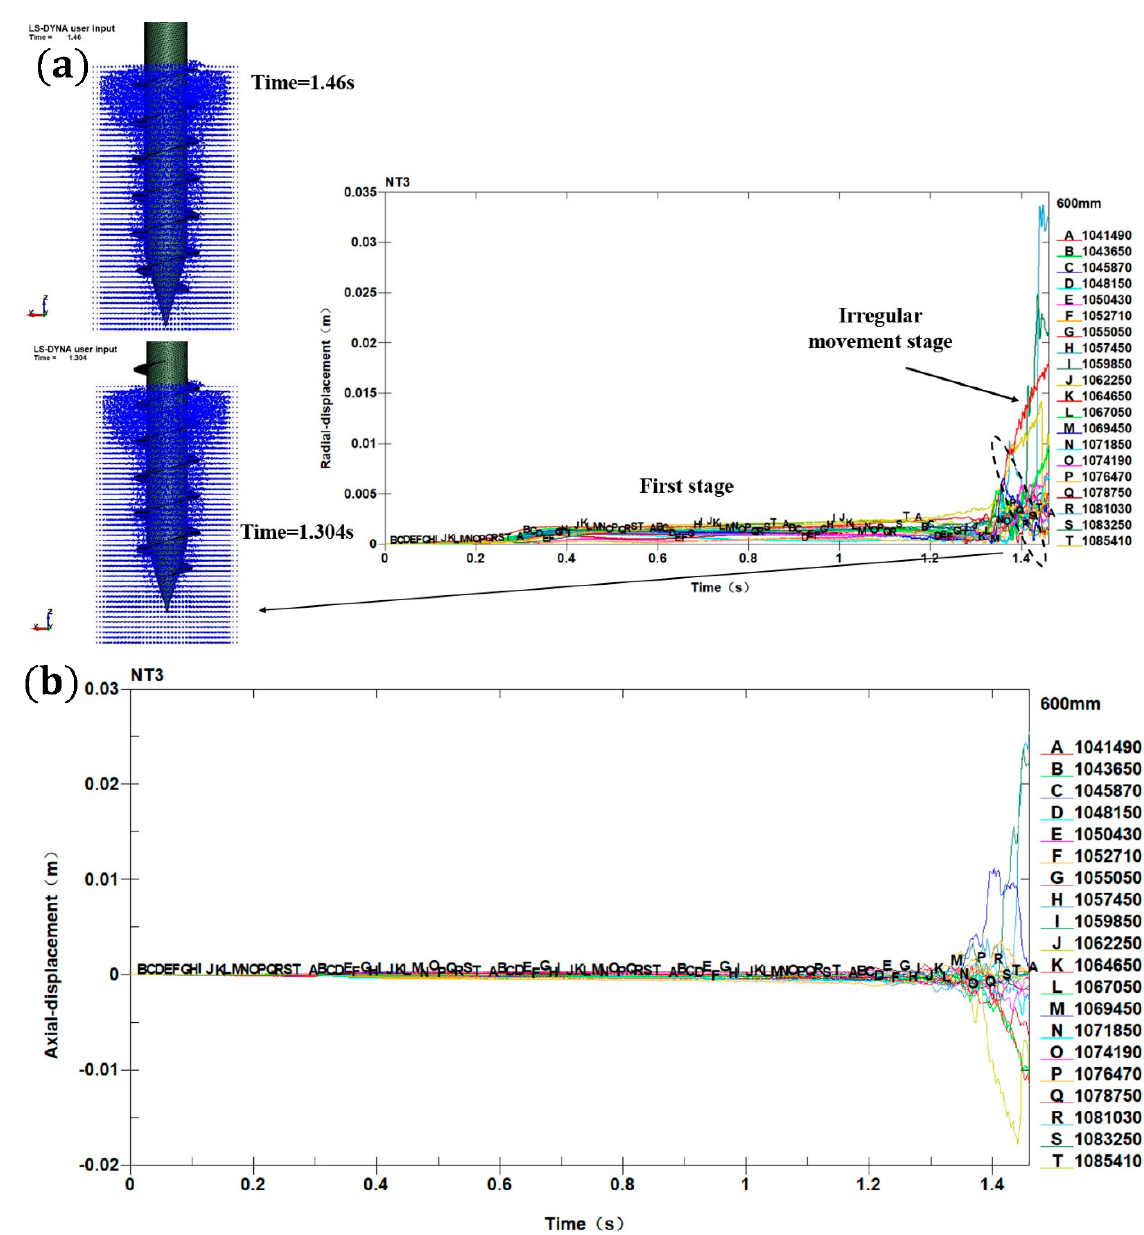
Figure 16. Displacement of the deep soil particles in different directions: ( a ) radial; ( b ) axial.